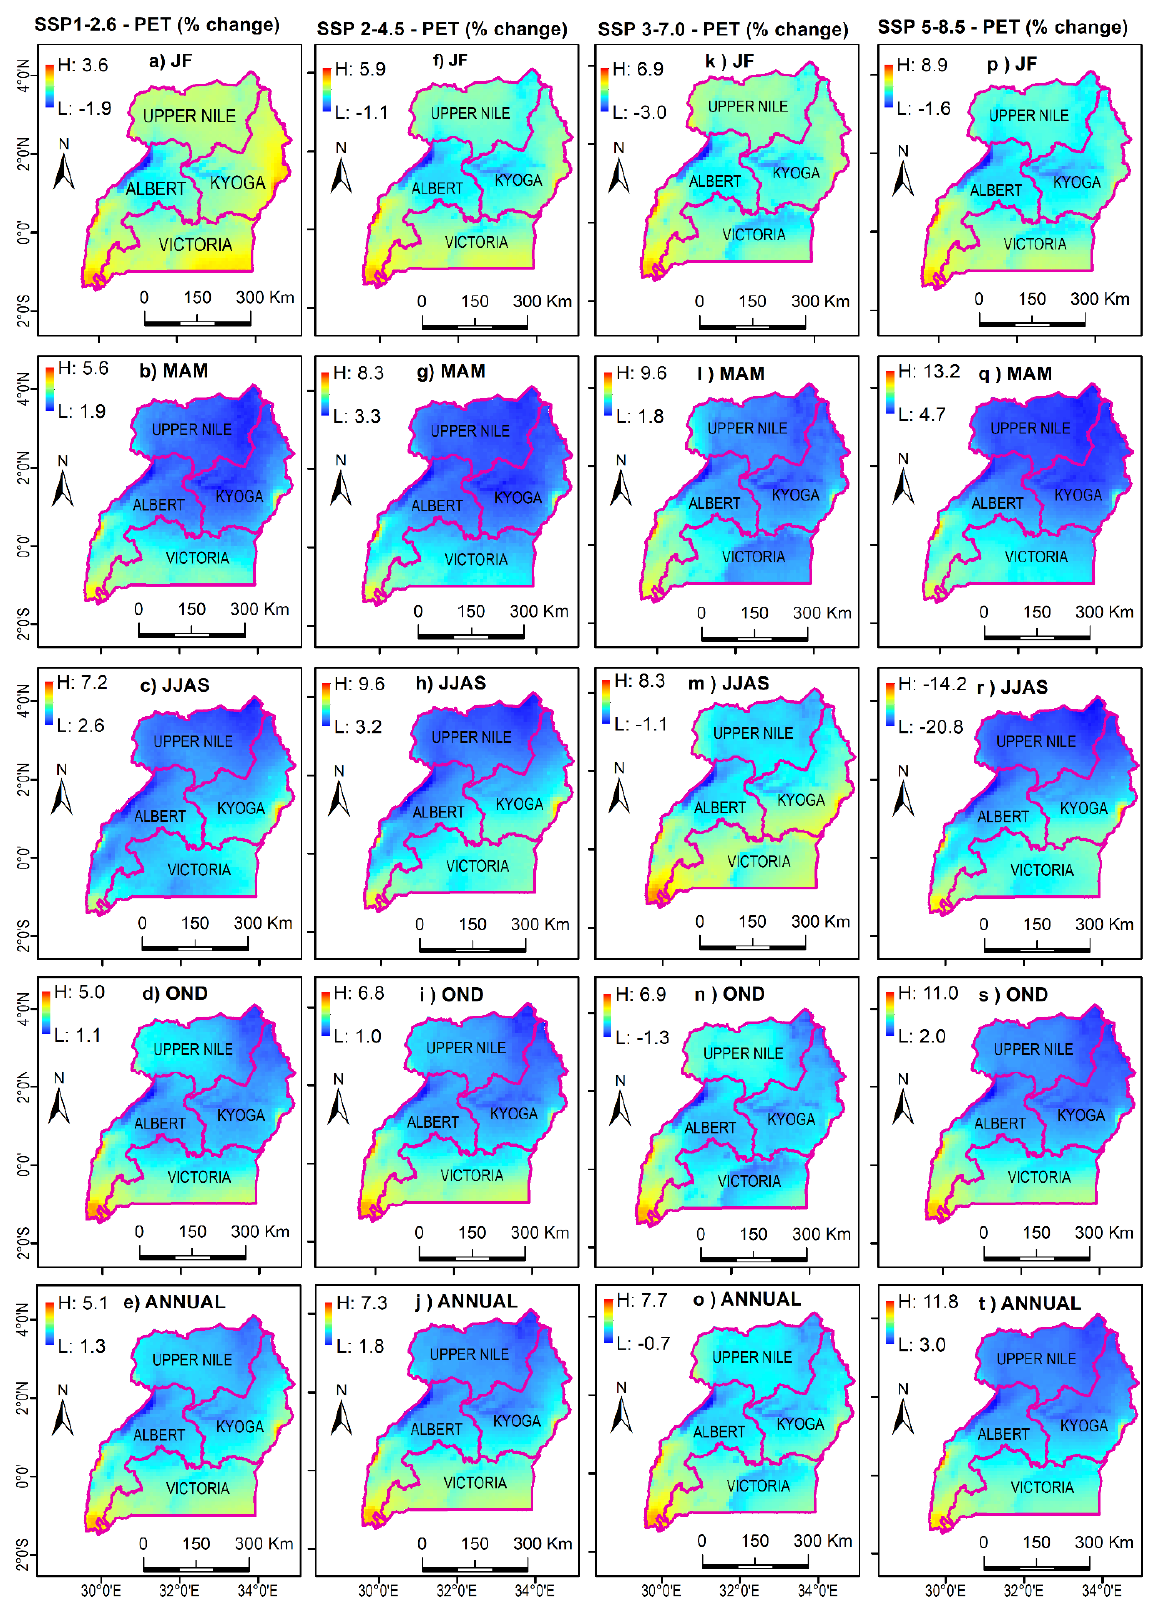
Figure A5. Percentage change in PET over the period 2061 – 2080.